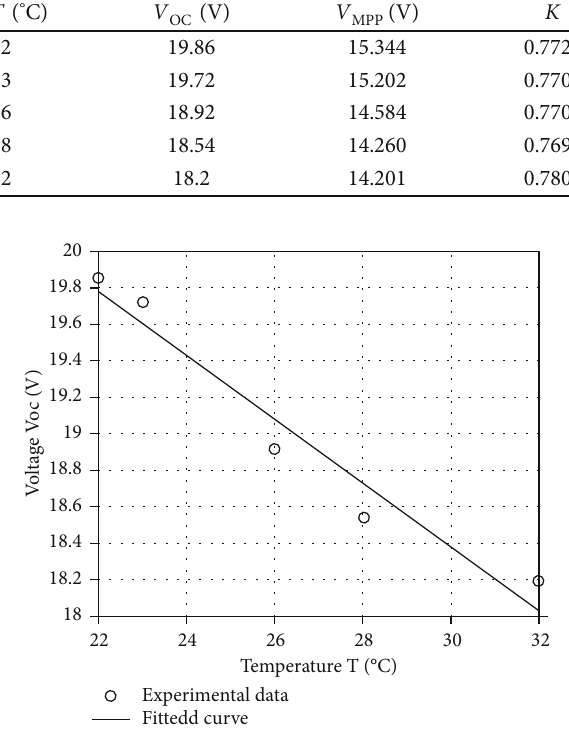
Figure 9: V OC response versus temperature